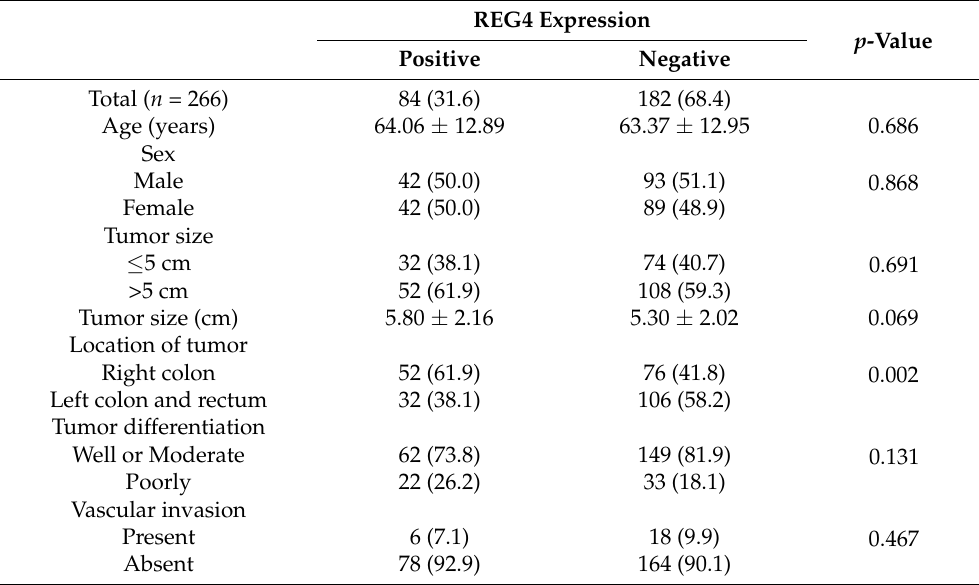
Figure 1. Representative immunohistochemical staining images for REG4 and intratumoral stroma. ( A , B ) Positive and negative REG4 expression in tumor cells (×400). ( C , D ) Low and high intratumoral stroma in colorectal cancer cases (×200). Table 1. The correlation between REG4 expression and clinicopathological parameters in colorectal cancers.